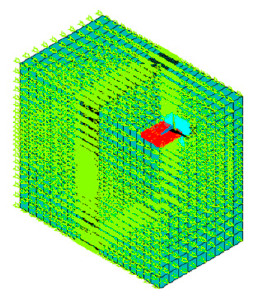
Figure 2. Fluid-solid coupling model.